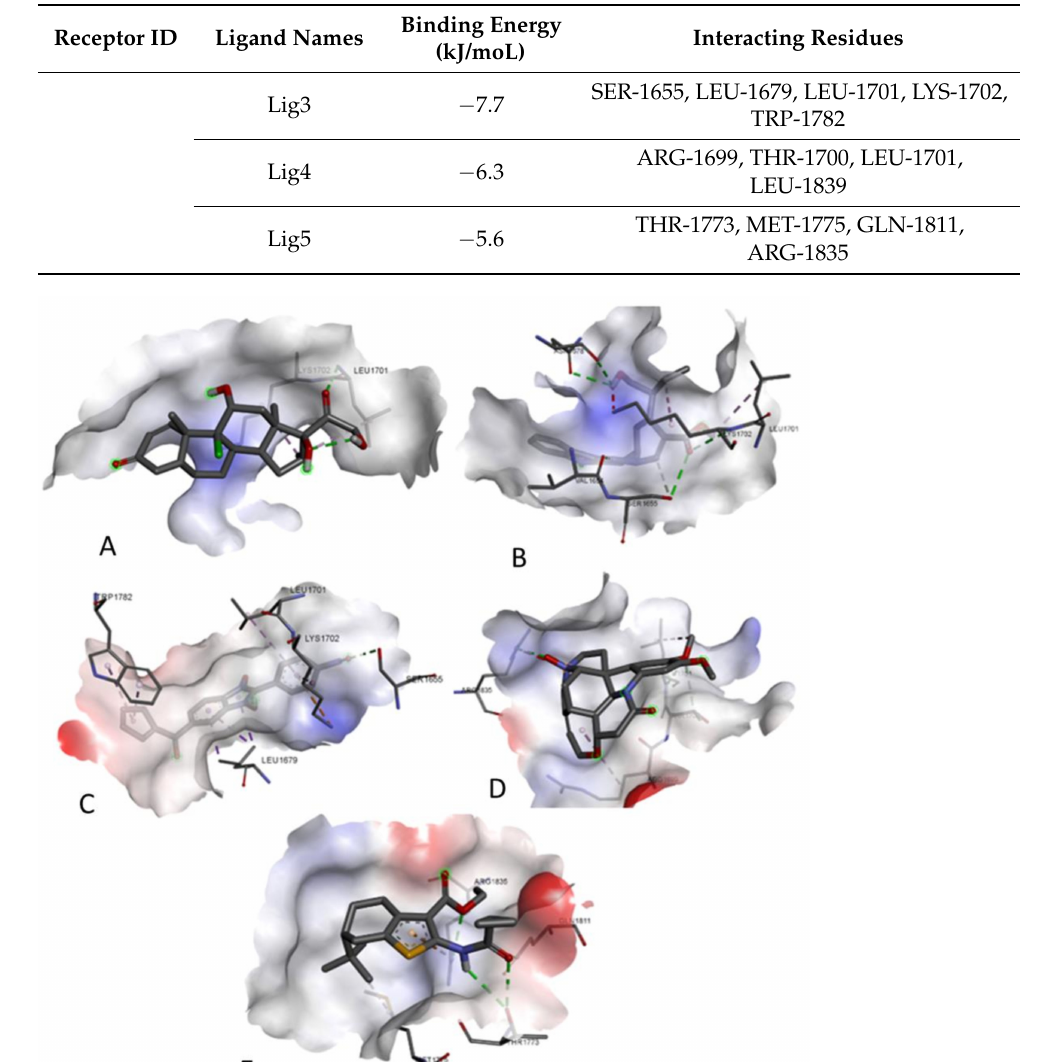
Figure 16. Molecular Docking Results of ( A ) lig1, ( B ) lig2, ( C ) lig3, ( D ) lig4 and ( E ) lig5 with BRCA1 cancer receptor